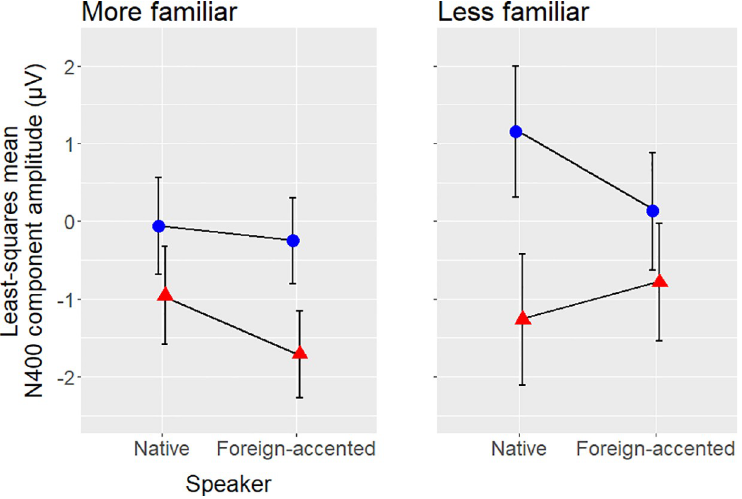
Fig 9. The relationship between N400 amplitude and accent familiarity. Least-squares mean amplitude values for congruous sentences are shown as blue circles, least-squares mean amplitude values for incongruous sentences are shown as red triangles. Error bars show 95% confidence